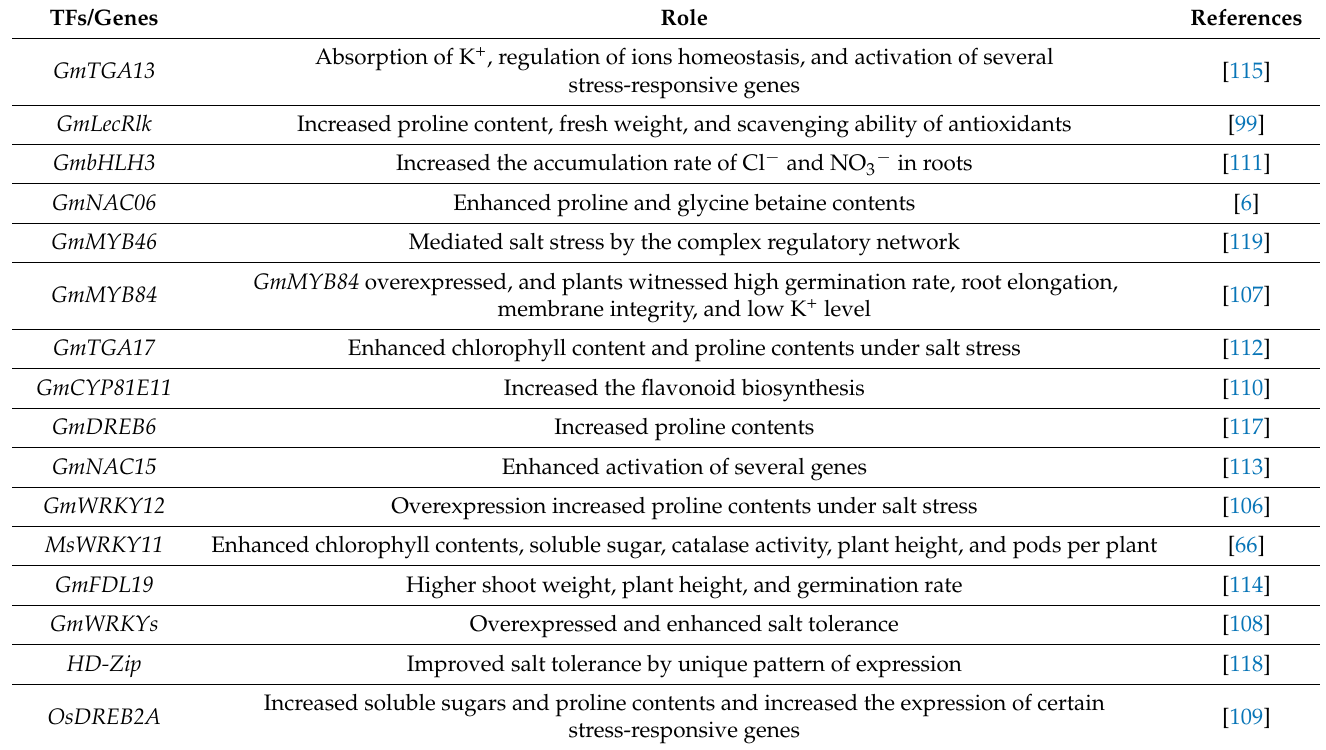
Table 6. Role of different TFs in salinity tolerance in